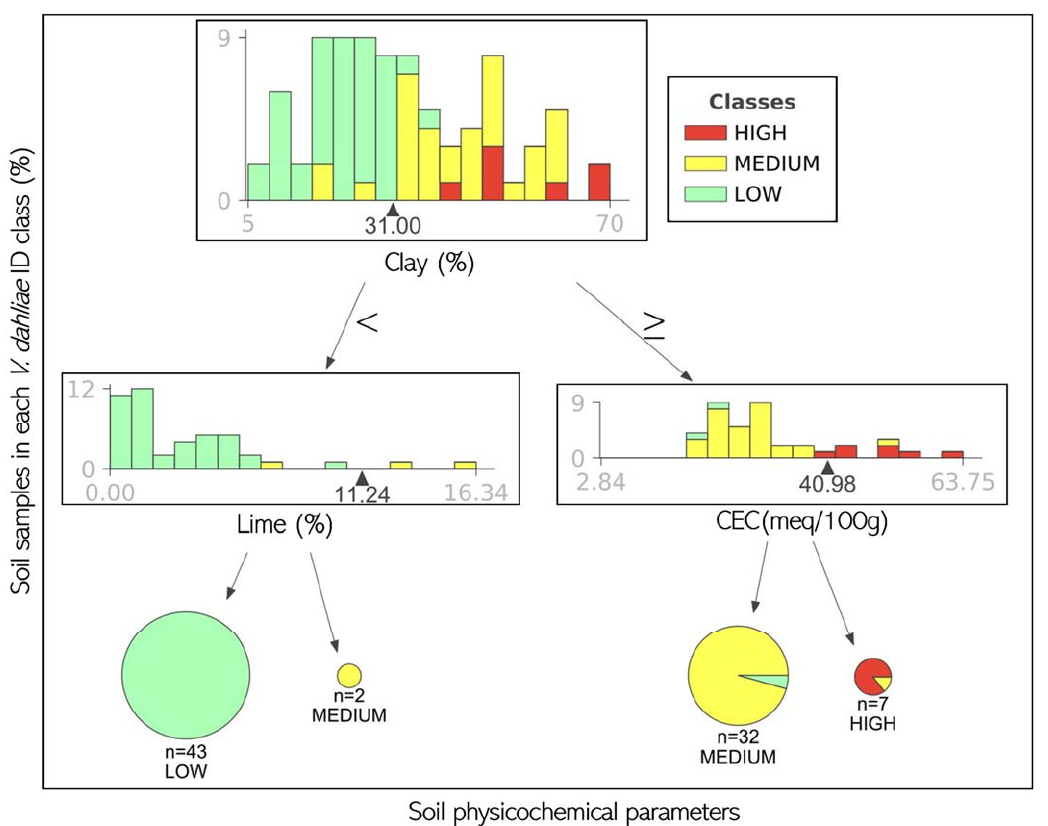
Figure 6. Pruned classification tree for predicting Verticillium dahliae inoculum density (ID) classes (low, medium, and high) in olive-growing areas of the Iberian Peninsula based on CEC (meq 100g − 1 ), Ca (meq 100g − 1 ), Mg (meq 100g − 1 ), Na (meq 100g − 1 ), K (meq 100g − 1 ), P (meq 100g − 1 ), lime (%), OM (%), pH, and percentage of clay, sand, and silt parameters. The histogram for each node represents the percentage of soil samples in each V. dahliae ID class. For each terminal (decision) node, the most prevalent V. dahliae ID class is indicated showing feature distributions as overlapping stacked histograms, one histogram per target class. Leaf size is proportional to the number of samples in that leaf. Data include a training set (75%) from a dataset (84 samples) comprising all experimental combinations of four previous cropping history groups (VWO—barely favourable, favourable, very favourable, and extremely favourable). Table 3. Classification report of a multilayer perceptron artificial neural network and a decision tree classifier directly run on the test set to estimate the relationship between the classes of Verticillium dahliae inoculum density in olive-growing areas of the Iberian Peninsula and several physicochemical